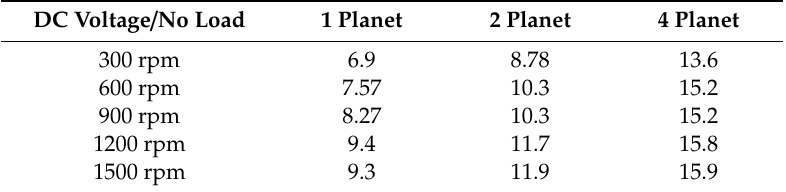
Table 3. Output DC Voltage for Different Planet Cover Numbers Measured with No Load.